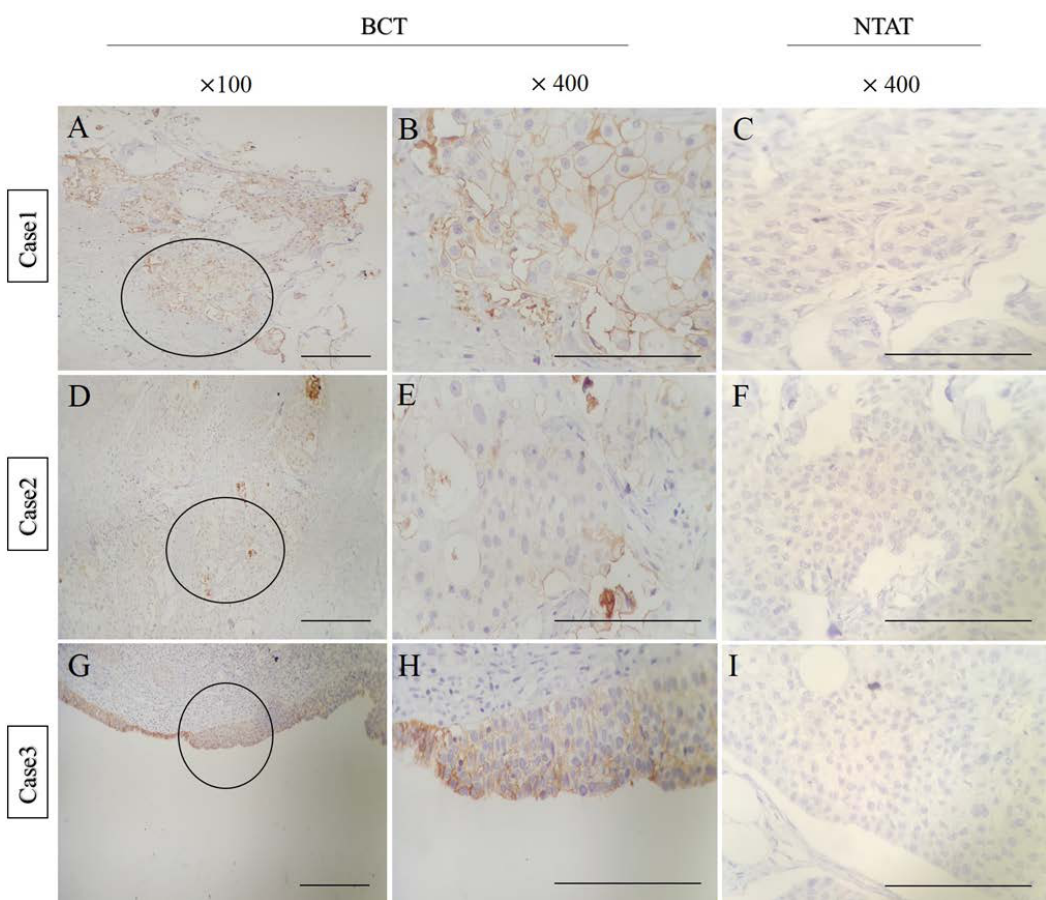
Fig. 4. Representative immunohistochemical staining for HE4 in three BCT and NTAT samples. High levels of cytoplasmic expression (++) in BCT samples were detected; A, D, and G: not observed in NTAT samples; C, F, and I: